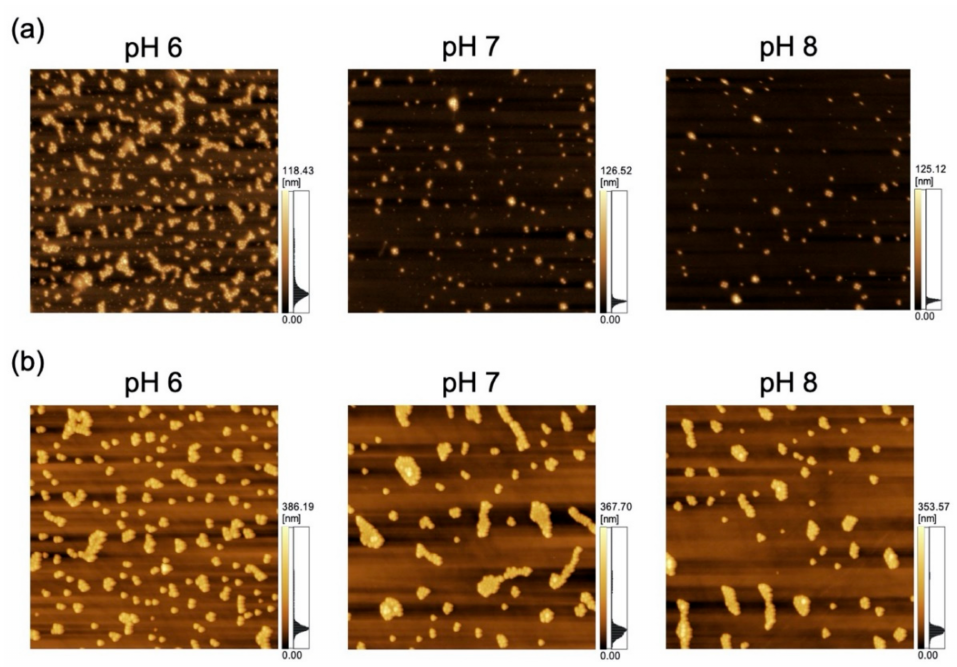
Figure 2. Atomic force microscopy (AFM) images of polydimethylsiloxane-based substrates im- mersed in variable-pH dispersions of ( a ) 100-nm nanoparticles (NPs; scan area = 8 µ m × 8 µ m) and ( b ) 250-nm NPs (scan area = 20 µ m × 20 µ